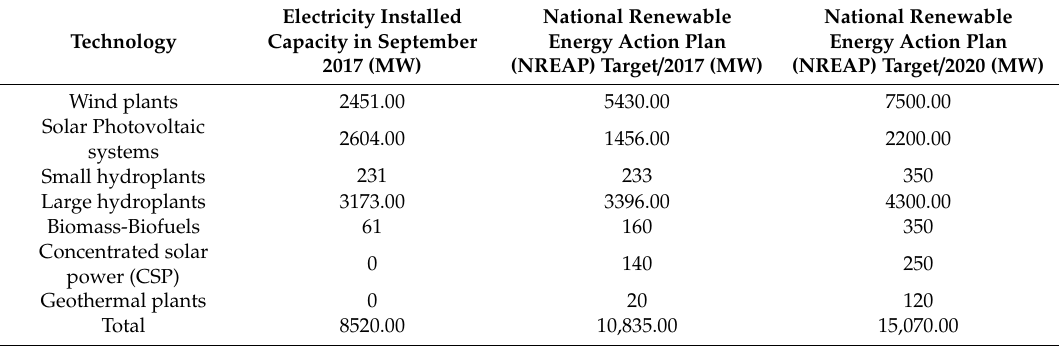
Table 1. RES electricity installed capacity per technology (September 2017) [10].